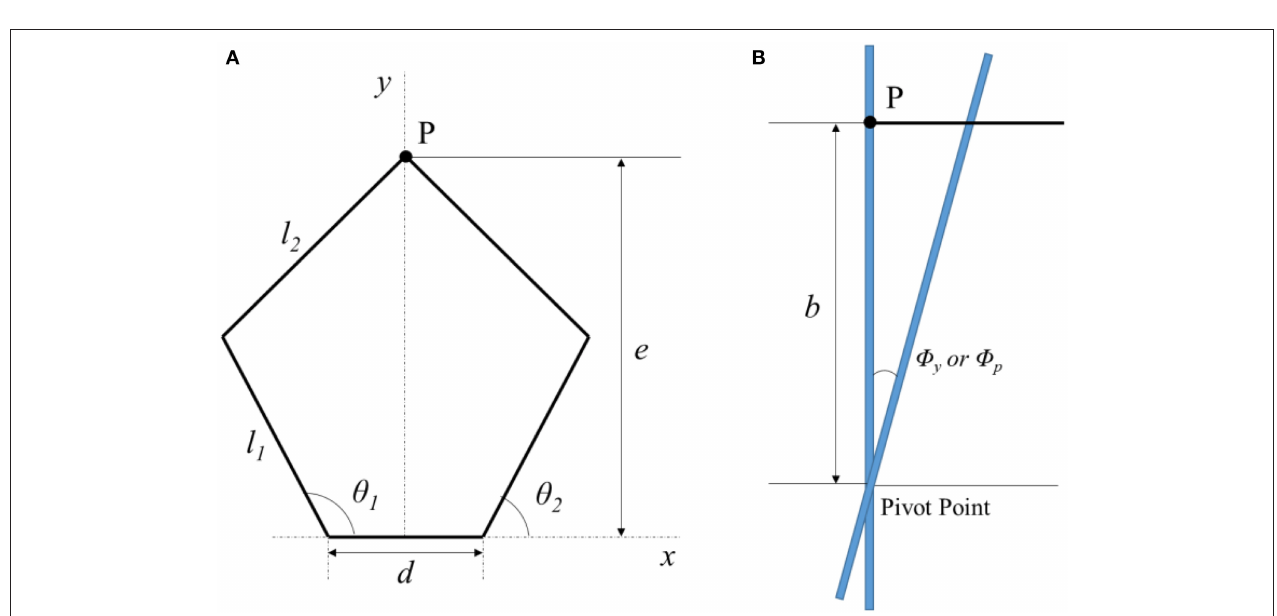
FIGURE 5 | Configuration for slave robot position determination. (A) Top view. (B) Side